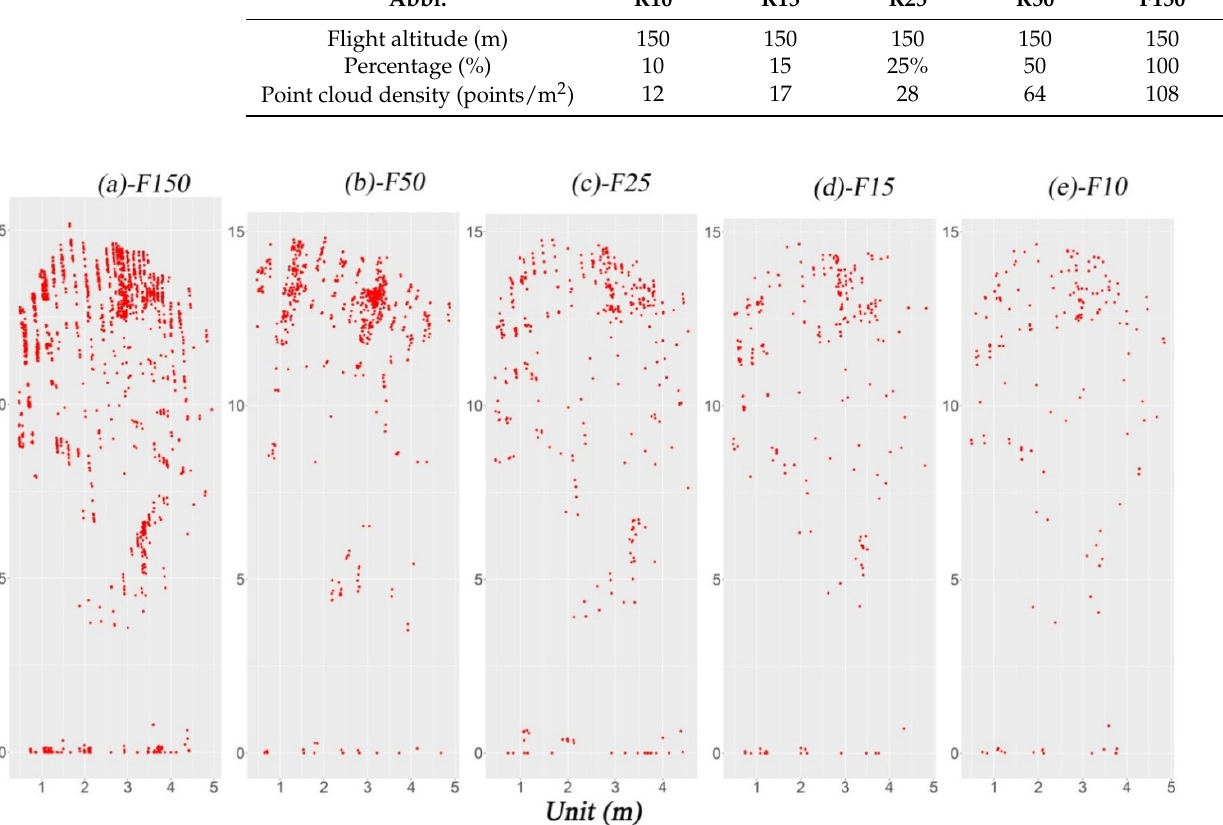
Table 2. Light detection and ranging (LiDAR) data density parameters of different point cloud densities. Abbr.